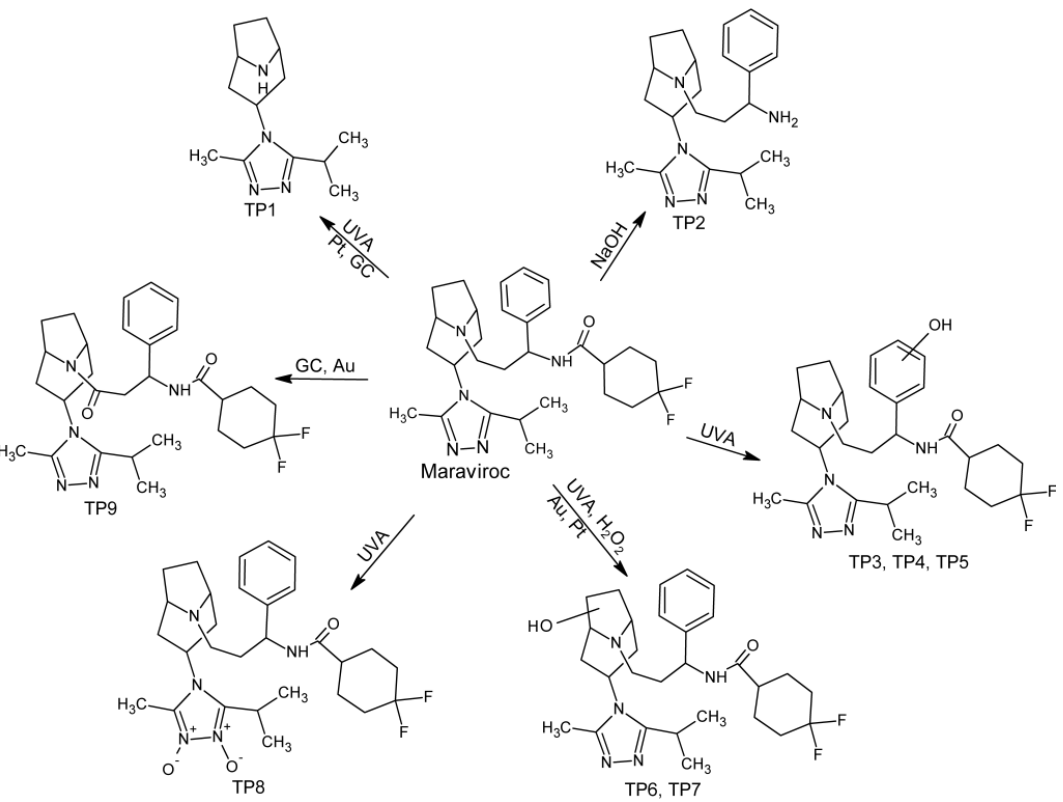
Figure 3. Forced degradation pathway of maraviroc in tested